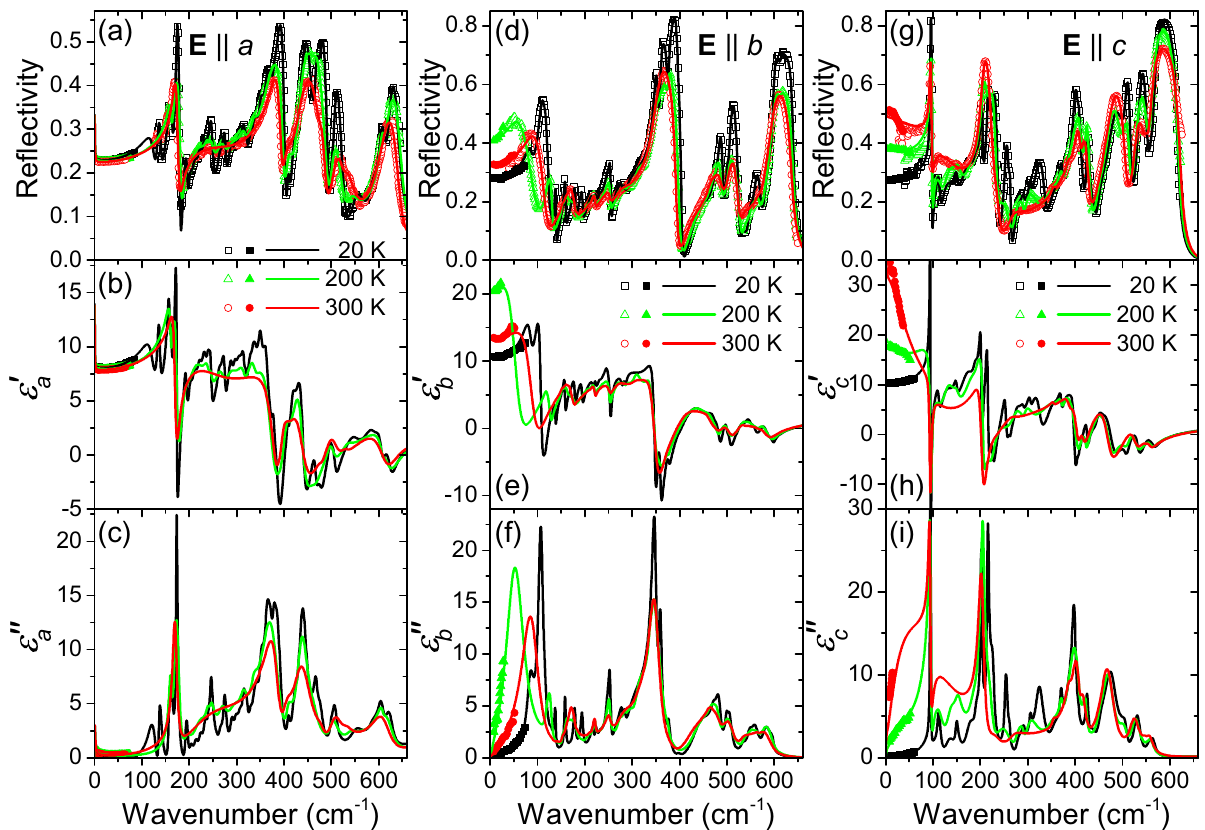
Figure 3. Comparison of polarized reflectance data and complex permittivity spectra of lawsonite in the IR range at 20, 200 and 300 K. Symbols below and above 100 cm − transmittance [calculated from the complex permittivity using Eq. (2)] and IR reflectivity measurements, respectively. Lines: spectra